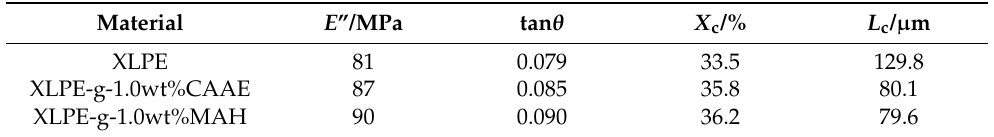
Table 2. DMA β relaxation peak magnitude (loss modulus E ” and factor tan θ ), crystallinity X c and water-tree dimension (characteristic length L c